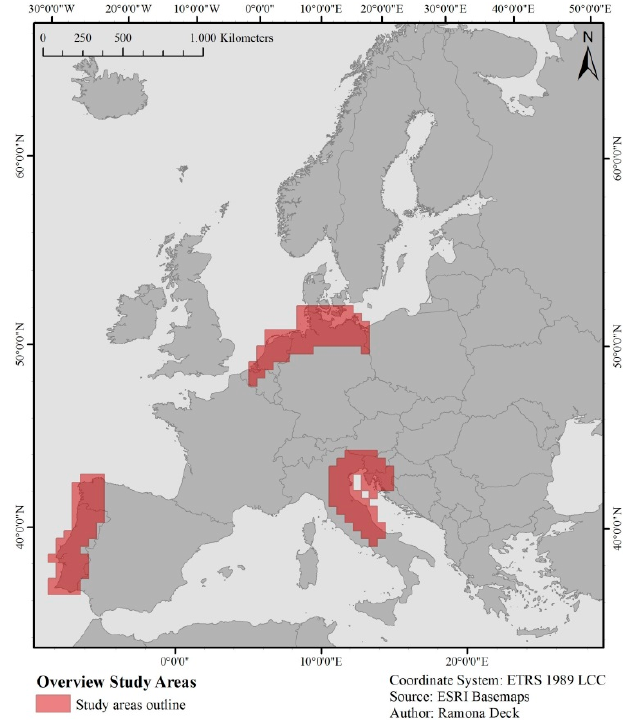
Figure 1. Overview of the three selected study areas in Europe with ‘Germany’ in the north, ‘Portugal’ in the west, and ‘Italy’ in the south.